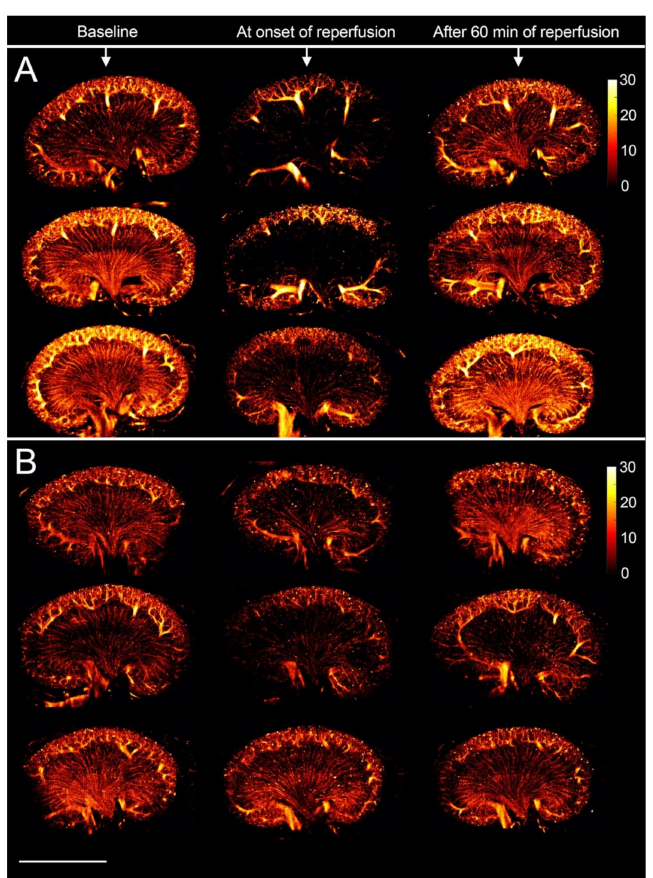
Figure 4. ( A ) Super-resolution images (log-scaled, i.e., color bar shows the value of intensity after logarithmic compression, ranging from 0~30 dB, and intensity corresponds to the number of microbubbles) of three rat kidneys before and after clamping of the renal vein. ( B ) Super-resolution images of three rat kidneys before and after clamping of the renal artery. Scale bar: 10 mm. Six blinded assessors correctly identified the five scans as the onset of reperfusion after vein clamping, while the percentage of correctly identified scans at the onset of reperfusion after artery clamping was only 60%. The assessors were not able to distinguish the baseline scans from the scans after 60 min of reperfusion. For the vein clamping, 63% were correctly identified as baseline or 60 min of reperfusion. For the artery clamping, 40% were correctly identified as baseline and 30% as 60 min of reperfusion. The fixed-marginal kappa was 0.60, showing only moderate agreement among the assessors. When evaluating all the SR scans in the correct order, the assessors correctly identified 67% as either vein or artery clamping. The power Doppler scans visualized only the cortical blood flow. After 60 min of reperfusion, all the power Doppler images showed a decrease in the cortical blood flow compared with baseline (exemplified in Figure 5). The assessors correctly identified all of the 20 power Doppler scans as either baseline or 60 min of reperfusion, and correctly identified 80% as either vein or artery clamping. All power Doppler images as well as the image assessment results are available in the Supplementary Materials in Figures S3 and S4 and Tables S2–S6,